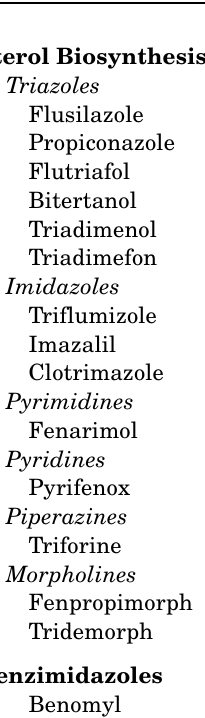
and MIC of different fungicides for inhibition of mycelial growth of the wild-type strain wt-B Table 1. EC 50 Botrytis cinerea .